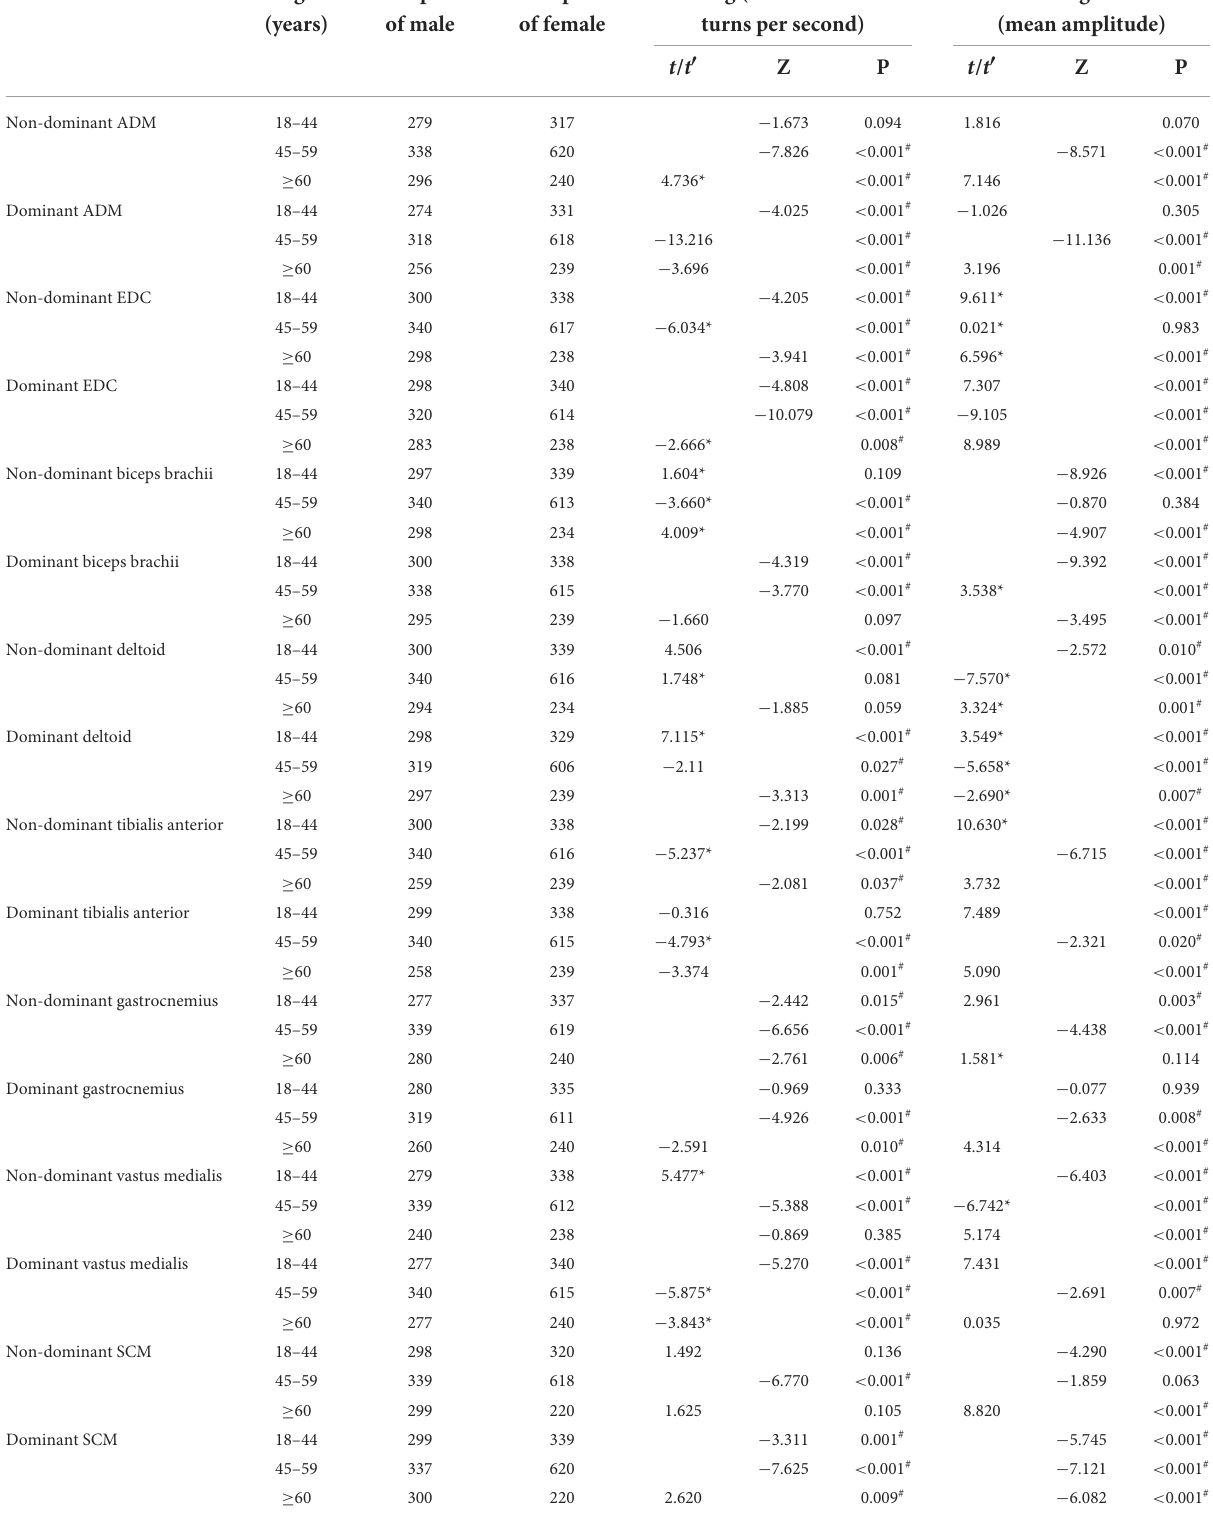
TABLE 3 The comparison of the results of lg (number of turns per second) and lg (mean amplitude) for different genders groups.